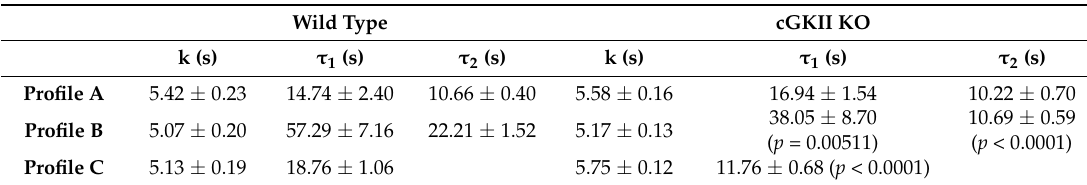
Table 2. Time constants of exocytosis and endocytosis for the different response profiles after strong and sustained